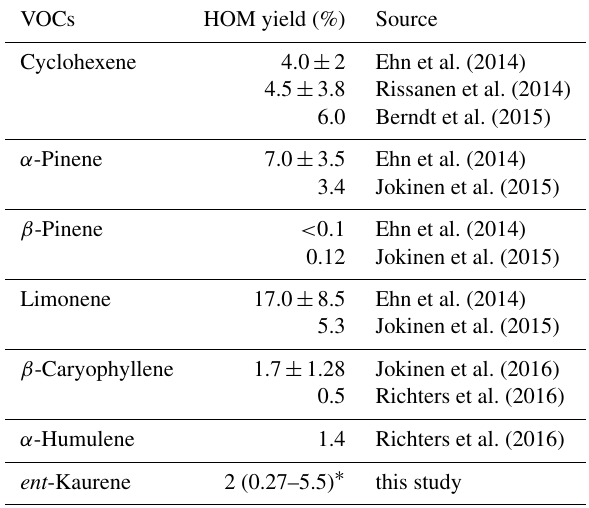
Table 1. The molar HOM yields from different atmospheric bio- genic VOCs ozonolysis. All HOM were detected using nitrate CI-